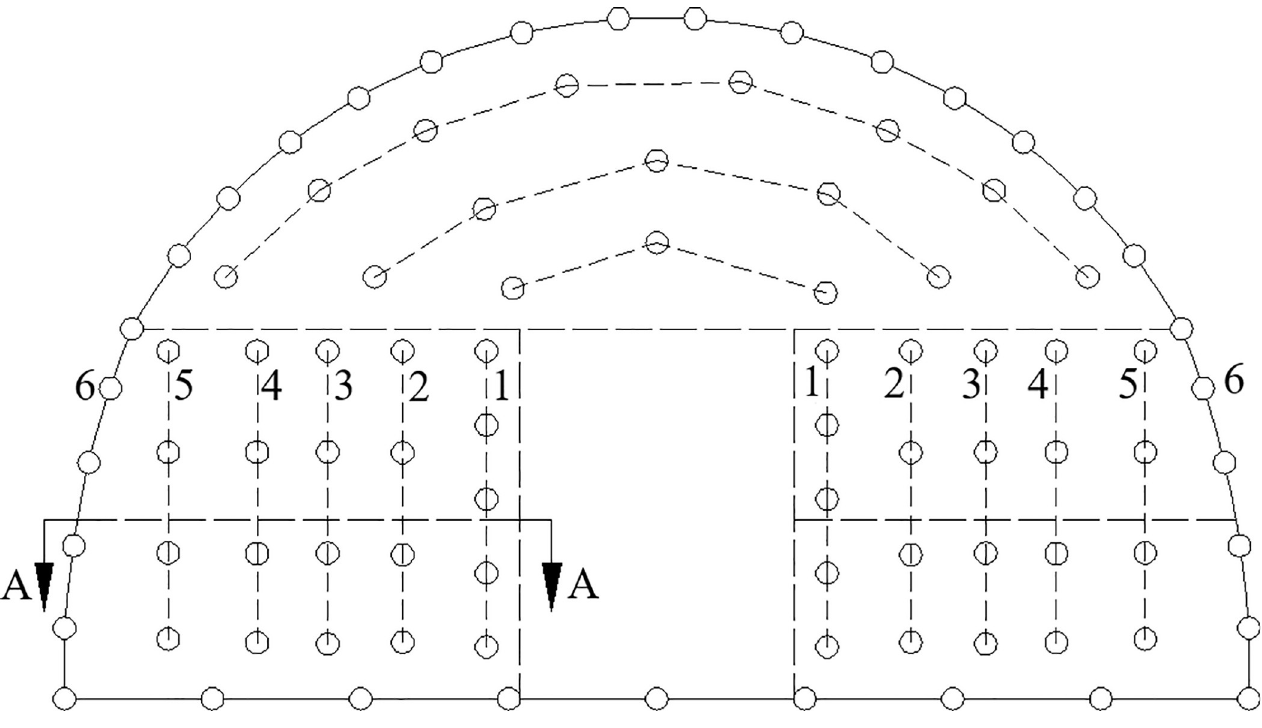
Fig 3. Front view of the wedge-shaped cutting blasting